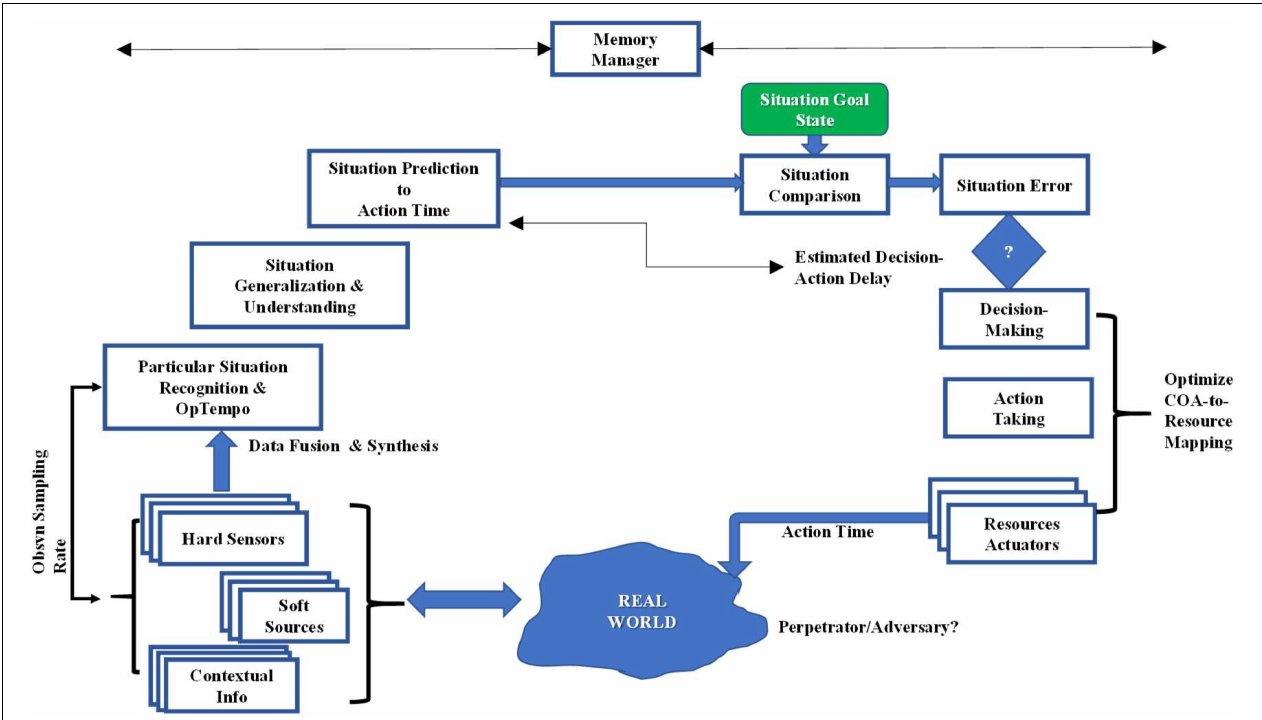
FIGURE 2 | Expanded framework of cognitive situation